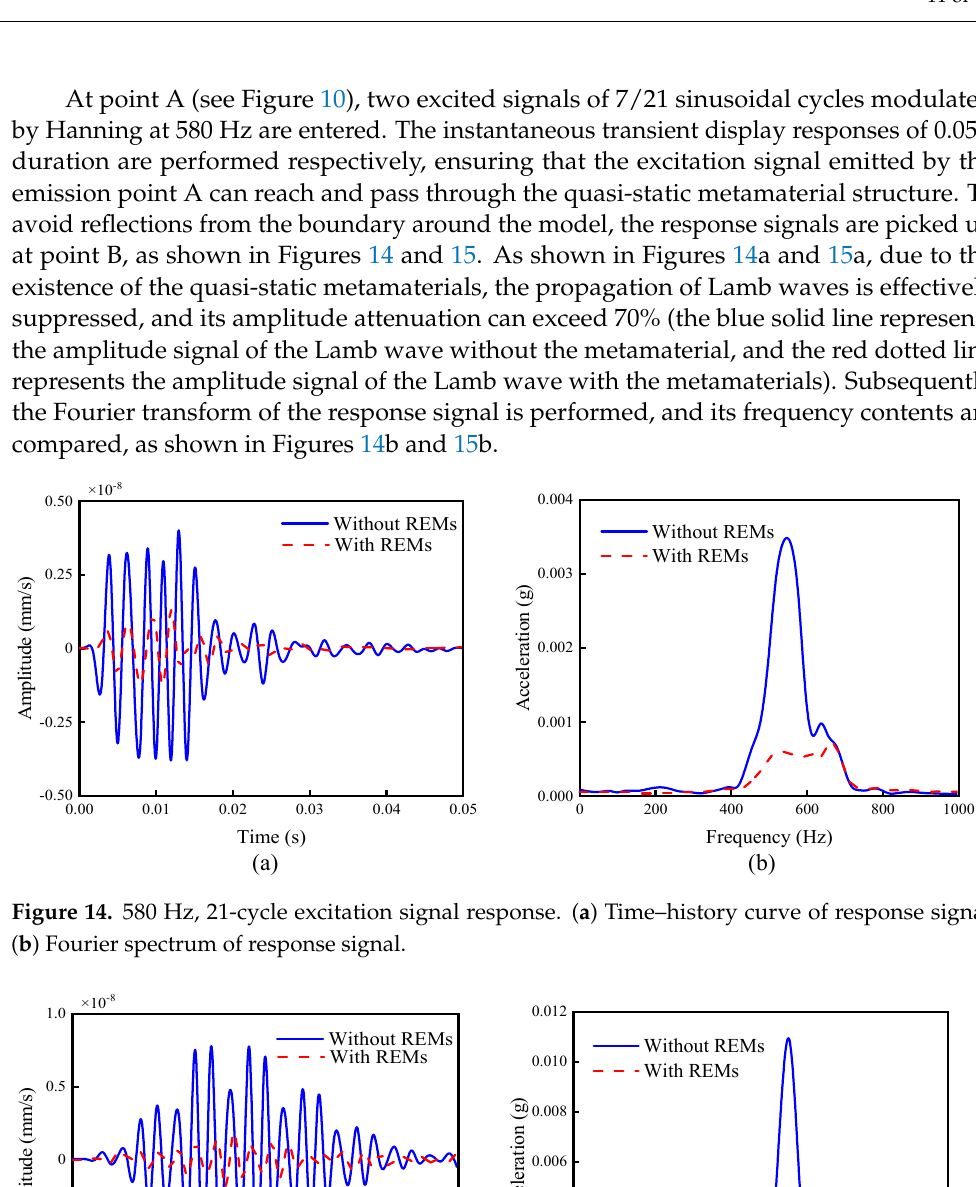
(b) Figure 13. 580 Hz, 21-cycle excitation signal. ( a ) Time–history curve of excitation signal and ( b ) fre- quency content of excitation signal. At point A (see Figure 10), two excited signals of 7/21 sinusoidal cycles modulated by Hanning at 580 Hz are entered. The instantaneous transient display responses of 0.05 s duration are performed respectively, ensuring that the excitation signal emitted by the emission point A can reach and pass through the quasi-static metamaterial structure. To